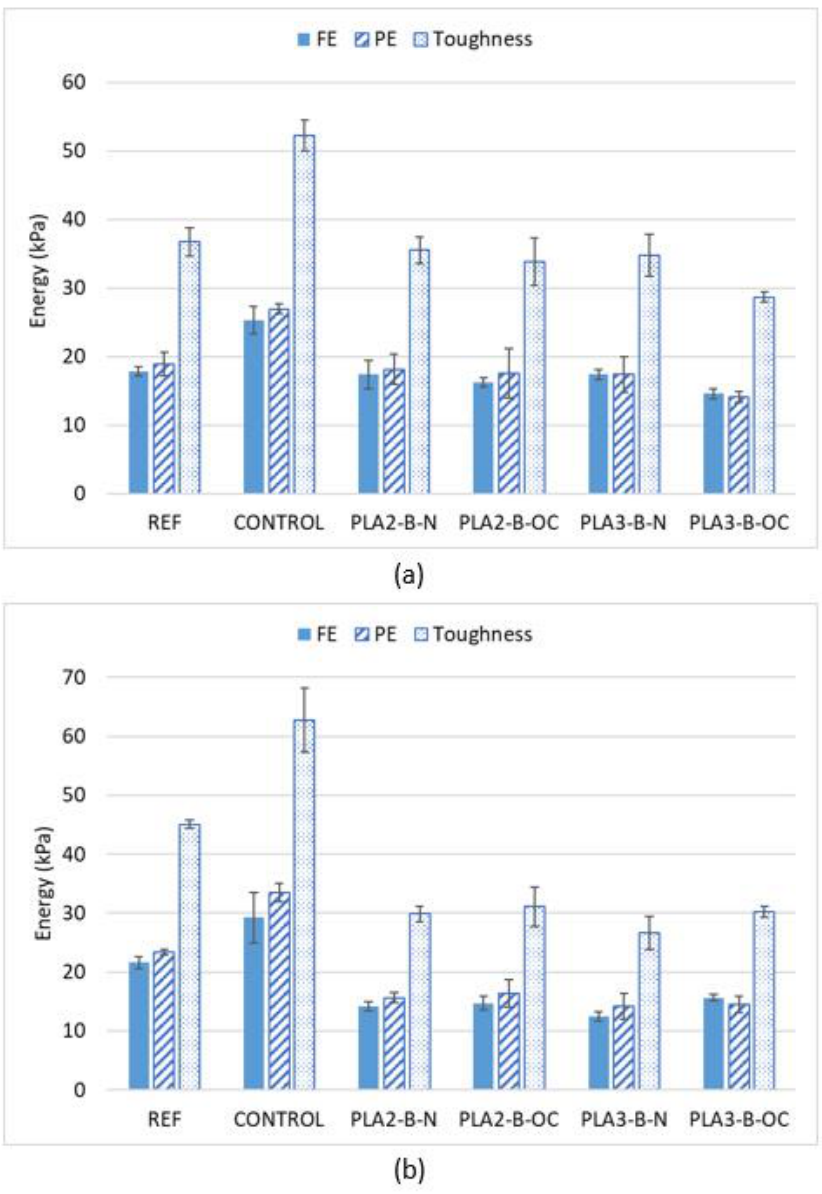
Figure 8. Fracture properties. Dry conditions ( a ); wet conditions ( b ).